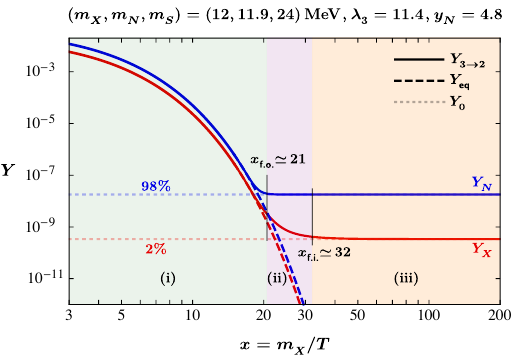
Figure 6 . The cosmological evolution of the comoving number densities of DM without including the two-loop induced 2 → 2 processes for r